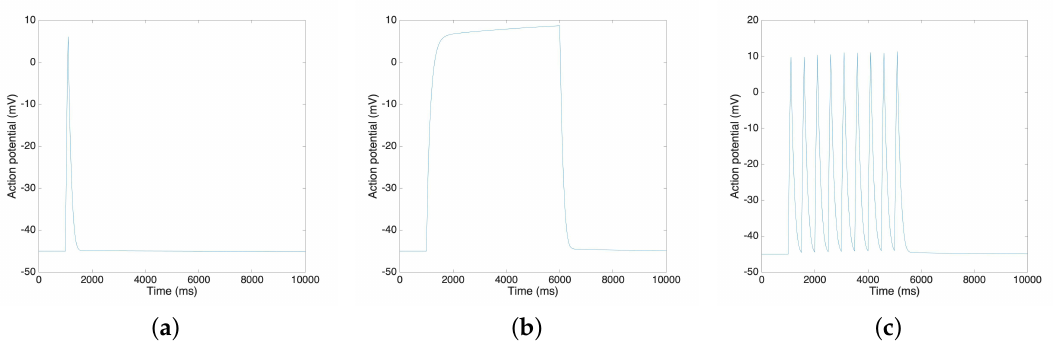
Figure 7. MATLAB simulation results of different types of action potential: ( a ) Single spike; ( b ) Plateau; ( c )